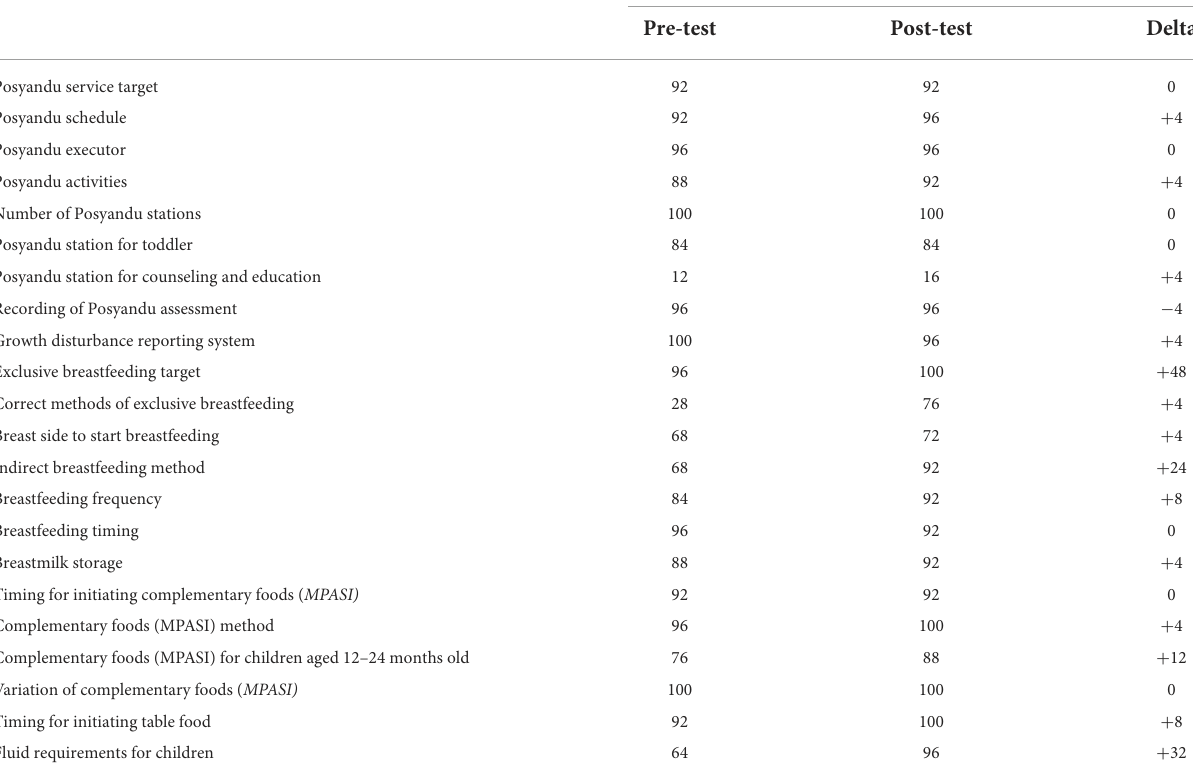
TABLE 2 Pre-test and Post-test results ( N =